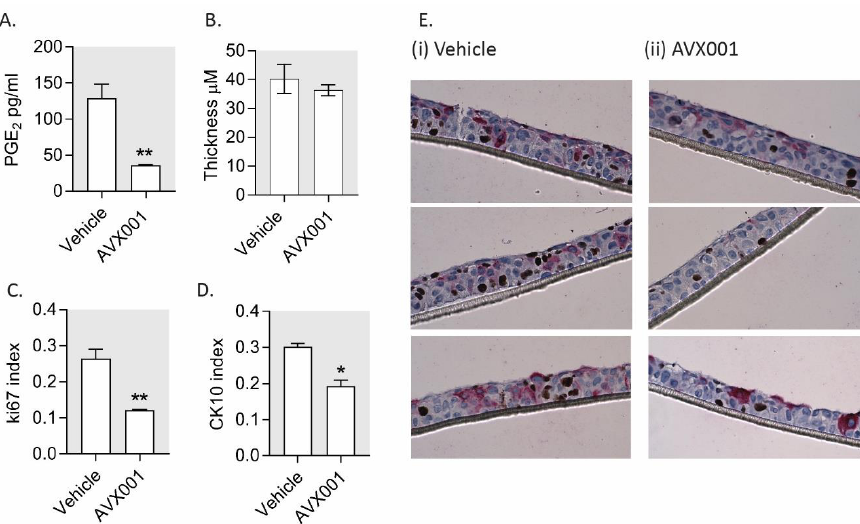
Figure 4. AVX001 inhibited proliferation in a stratified epithelium. HaCaT grown on porous collagen-coated membranes were maintained at the air–liquid interface for 12 days with exposure